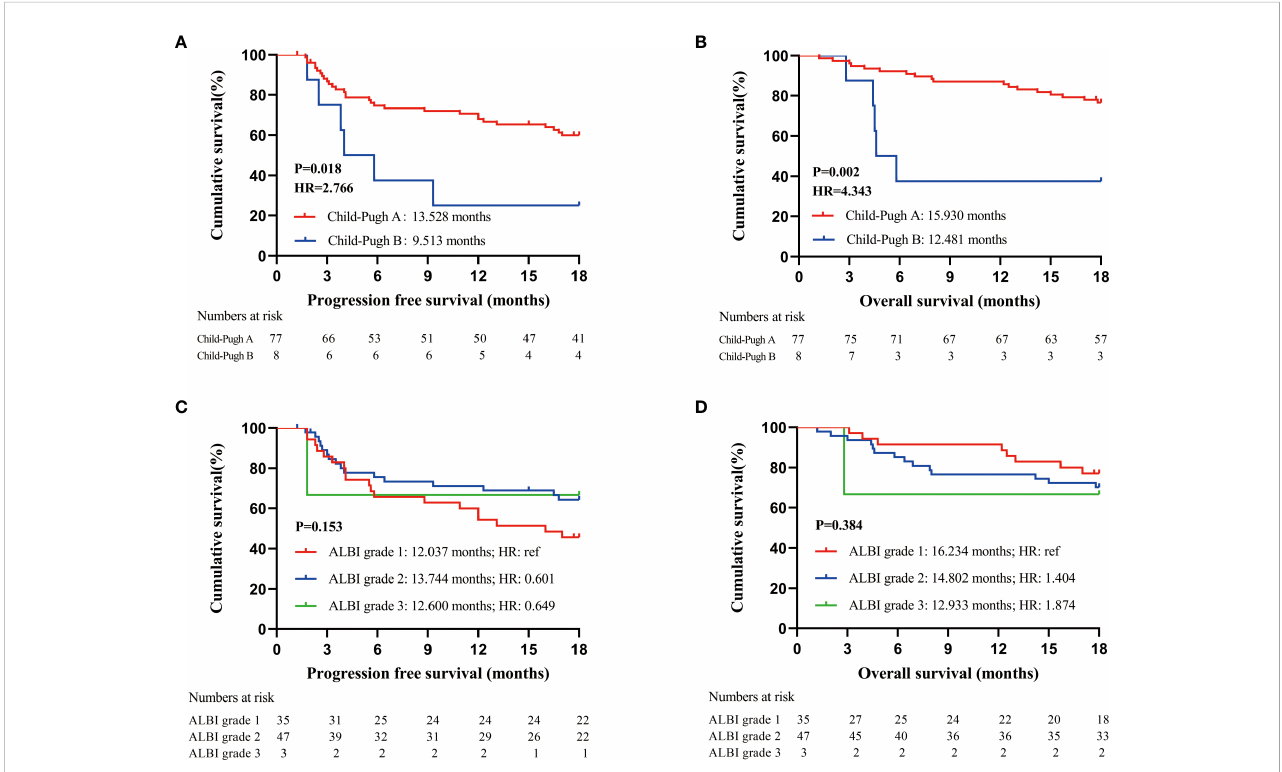
FIGURE 1 Prognostic analysis of patients receiving PD-1 inhibitors; (A) . PFS of all enrolled patients according to Child-Pugh grade at baseline; (B) . OS of all enrolled patients according to Child-Pugh grade at baseline; (C) . PFS of all enrolled patients according to ALBI grade at baseline; (D) . OS of all enrolled patients according to ALBI grade at